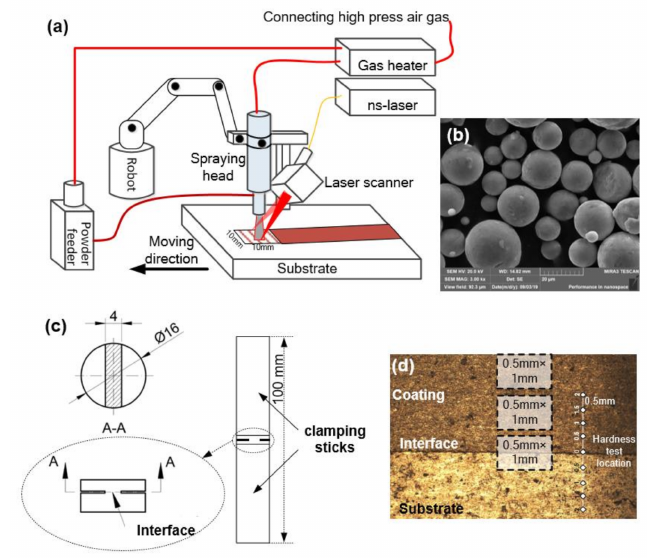
Figure 1. ( a ) Experiment setup of the nanosecond-pulse laser assisted cold spraying; ( b ) the SEM image of powder; ( c ) the tensile testing sample size; ( d ) analysis locations for porosity and hardness, the white box for porosity, the dot line for hardness.